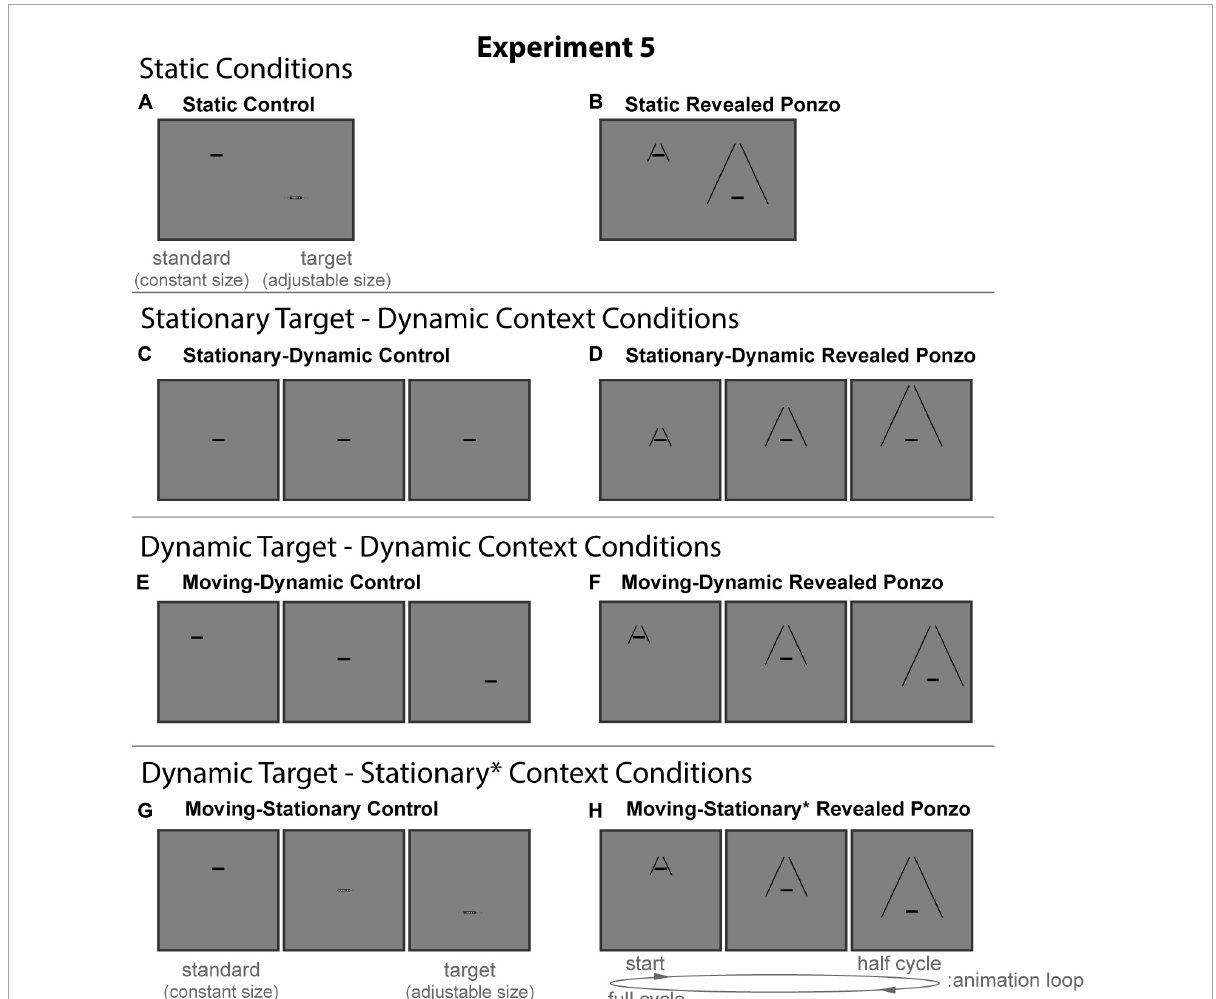
FIGURE10 The eight conditions of Experiment 5. Columns represent the two distinct contexts [Control (A,C,E,G) , Revealed Ponzo (B,D,F,H) ]. Rows represent the four configurations [Static (A,B) , Stationary-Dynamic (C,D) , Moving-Dynamic (E,F) , Moving-Stationary (G,H) ]. For each condition, screenshots for the beginning (standard circle), middle, and end (target circle) frames are shown. The animation [as labeled in panel (H) ] played in a continuous loop. In the figure, the horizontal line is the same physical size in all frames; during the experiment, the target (lower right line for Static conditions or the far-right frame for Dynamic conditions) was adjusted by the participant [see panels (A,G) ]. Here, stimuli are cropped to display the central portion of the screen to save space. Supplementary Video 5 showing all of the dynamic conditions for Experiment 5 can be found in the Supplementary materials (best viewed in “loop”